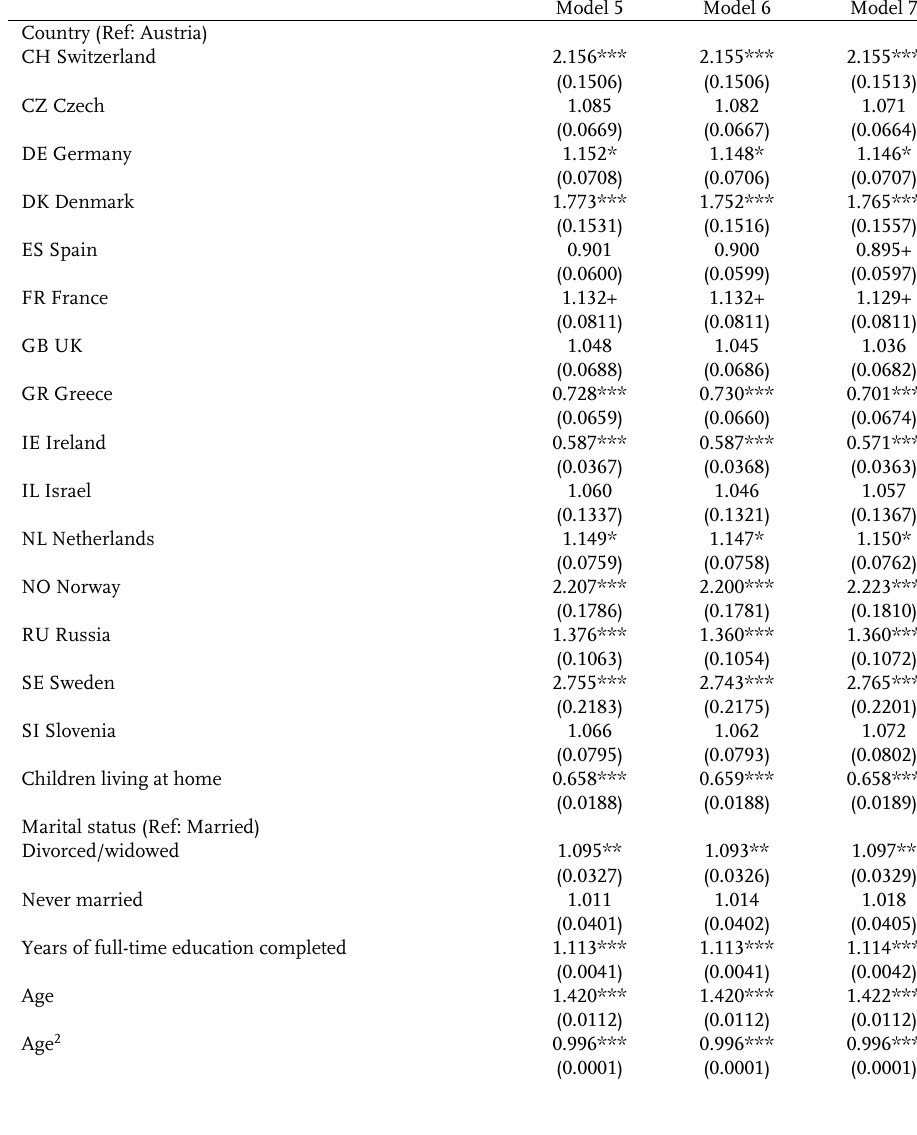
Table A.2 : Odd ratios role of religiosity and gender role attitudes on employment likelihood of women in different religion over time (Model 1, 2, 3 and 4 are in Table